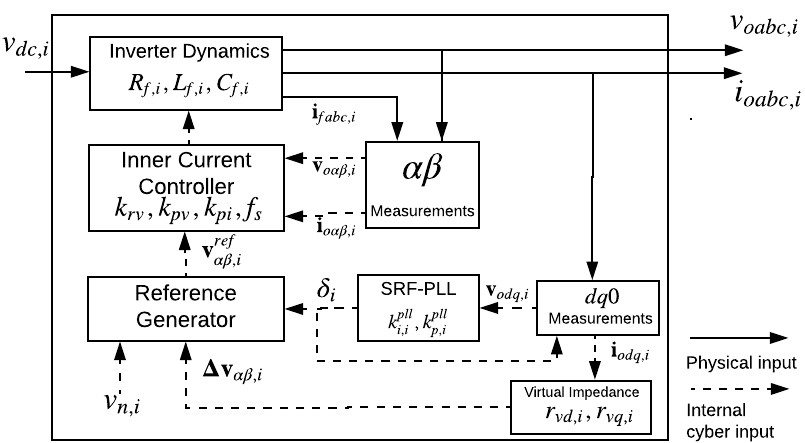
Figure 9. IDG CPES module (SRF virtual impedance